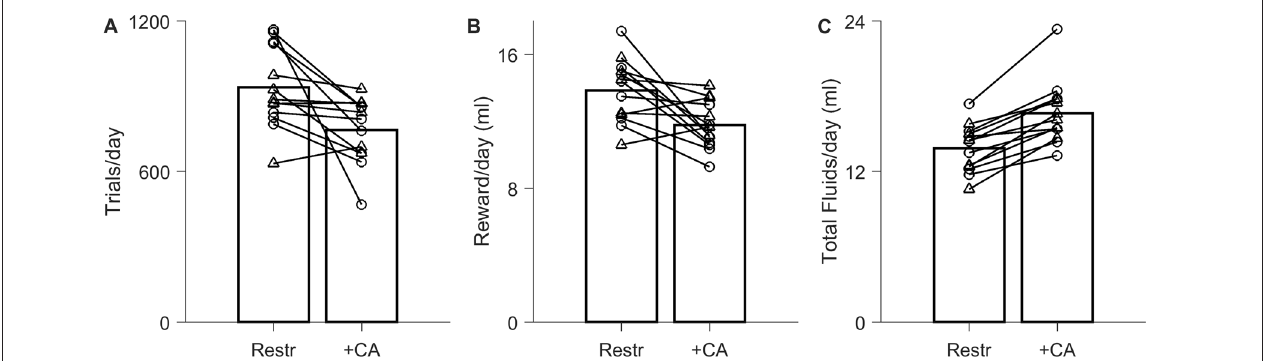
FIGURE 2 | Effect of ad lib CA water on motivation to work for water rewards in a live-in testing protocol. Data from N = 13 experiments on N = 7 rats. The ad lib water contained either 2% CA (circles, N = 7) or 4% CA (triangles, N = 6). (A) Average trial rate with 24 h/day task access, when the only source of water was task rewards (Restr) vs. when ad lib CA water was also present 24 h/day (+CA). Bars indicate population averages; lines indicate the N = 13 paired comparisons. (B) Total rewards earned per day in the water-restricted condition vs. ad lib CA condition. (C) Total fluid intake (sum of earned rewards and ad lib CA water consumption).